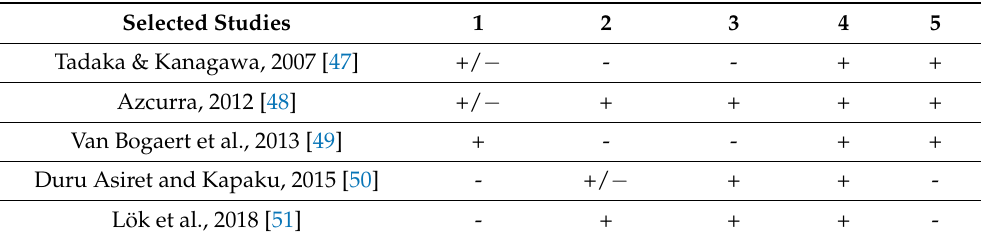
Table 1. Evaluation of methodological criteria used by the RCTs examining non-pharmacological intervention for elderly people with dementia.